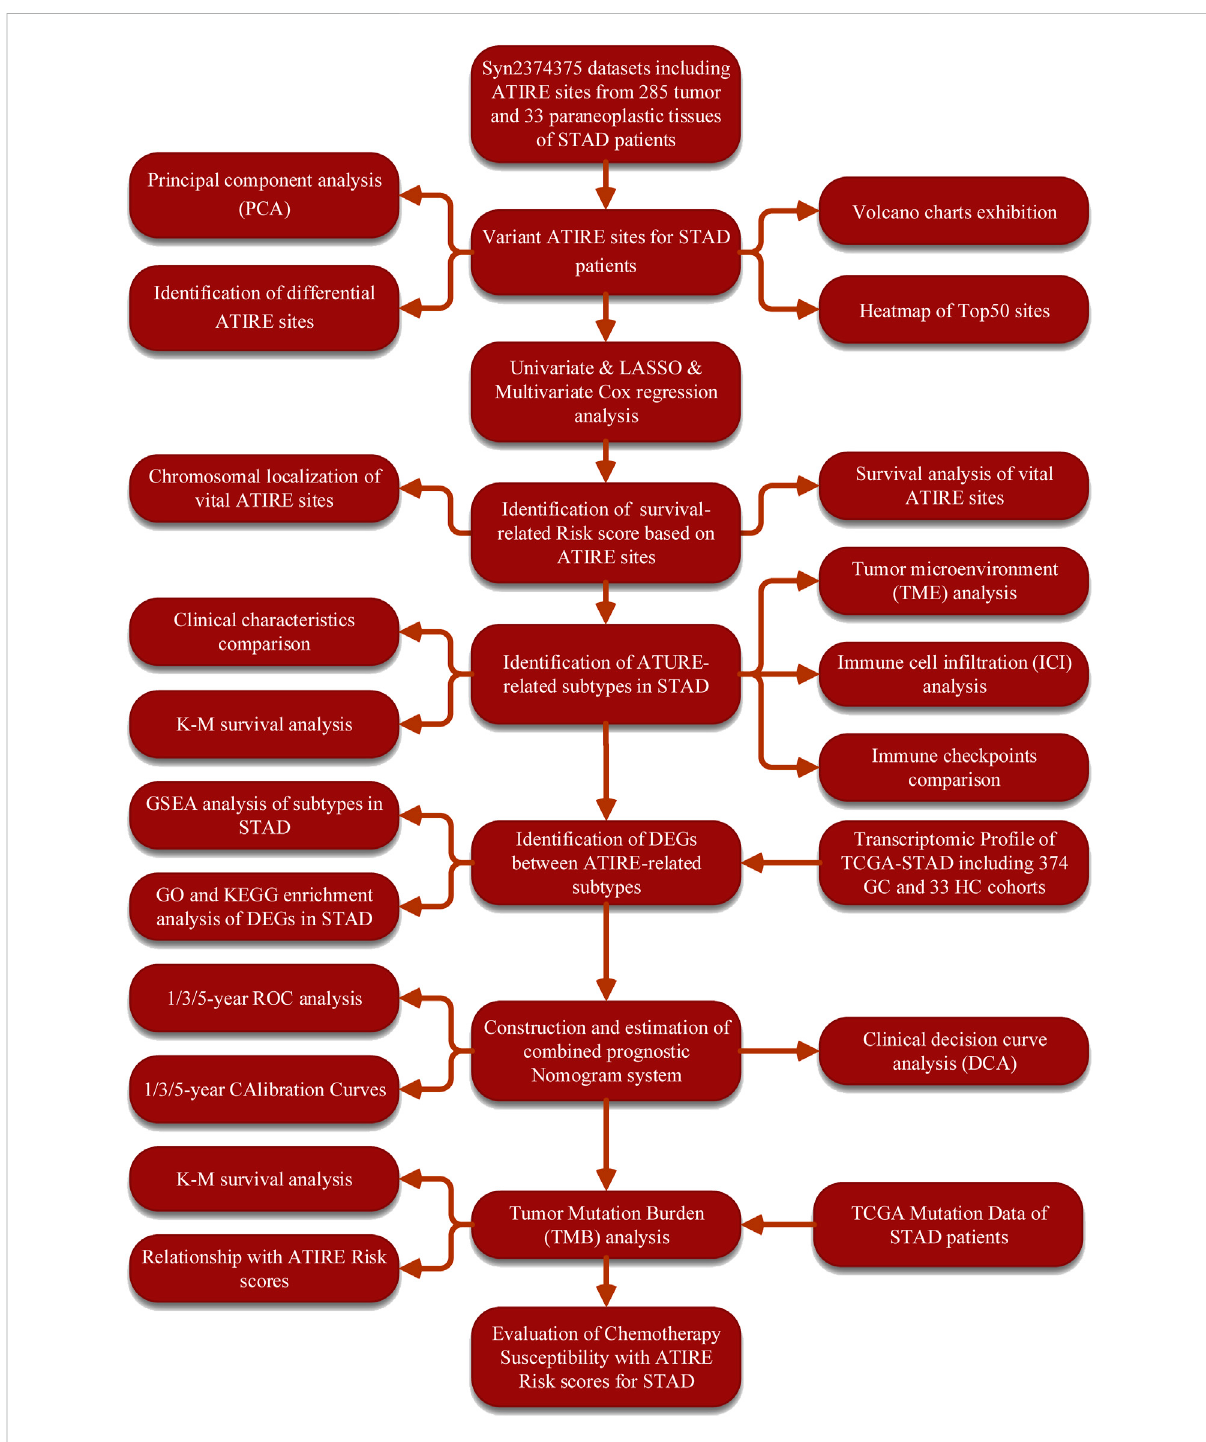
FIGURE 1 The fl ow charts of the work fl ow in our